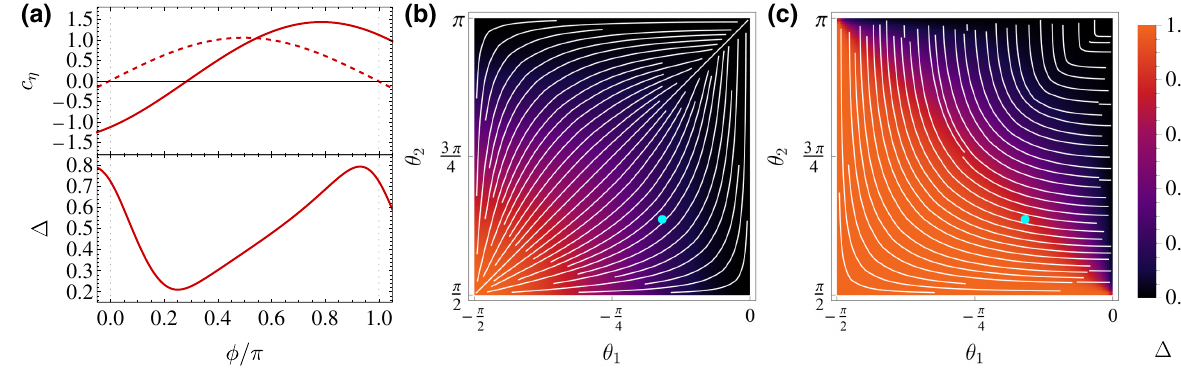
FIG. 3. (a) The dependence of driving parameters c 1,2 (solid and dashed lines respectivelly) and rescaled leakage (cid:15) with respect to the desired direction of travel φ at the point (θ 1 , θ 2 ) = ( − 0.5, 2.0 ) [marked by a light blue point in panels (b) and (c)]. The lowest value of (cid:15) determines the optimal direction. (b) The heat map shows the value of minimal leakage, and contour lines indicate the optimal direction in the parameter space of the MPS. Panel (c) illustrates the maximal possible magnitude of the leakage along with the direction where it is